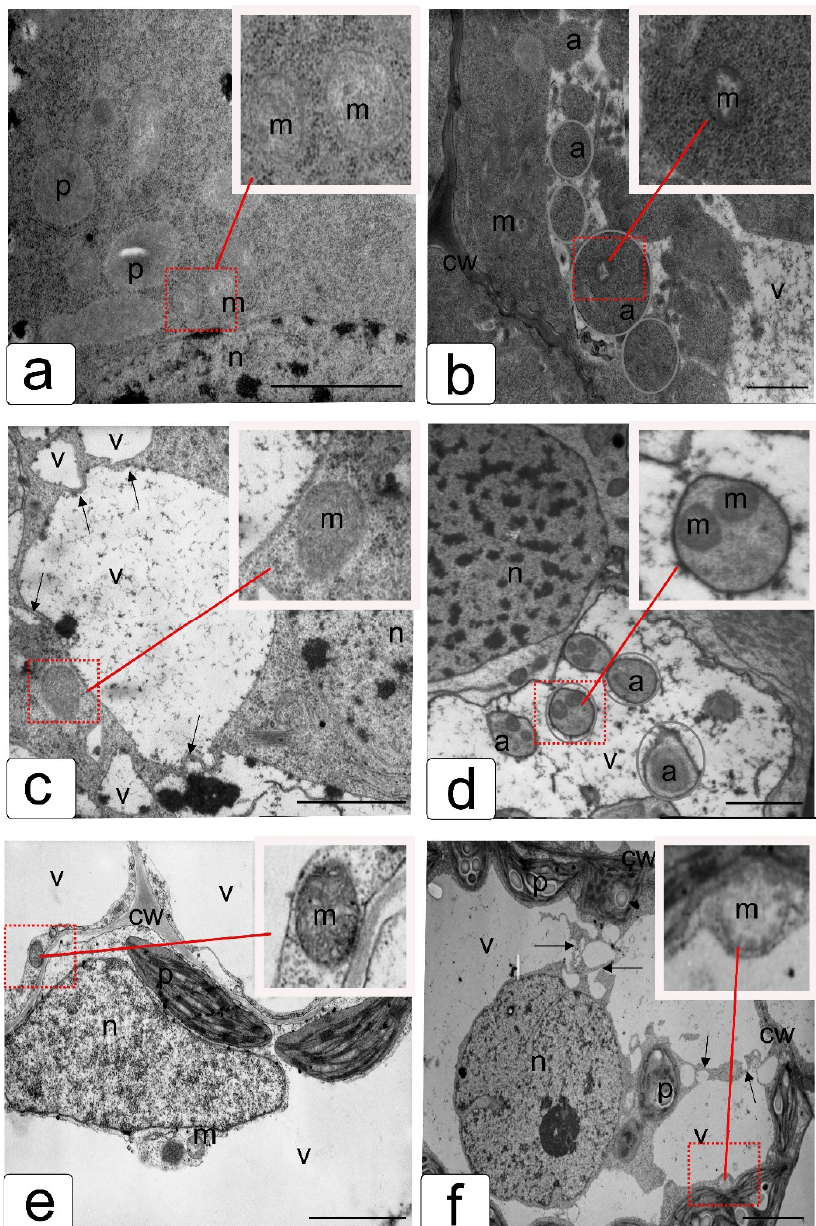
Figure 4. Formation and fusion of vacuoles and autophagosomes in cells of the root cortex ( a – d ) and aerial part ( e , f ) under control conditions and ( a , c , e ) under the influence of 150 mM NaCl. Designa- tions: p—plastid; m—mitochondria; cw—cell wall; n—nucleus; v—vacuoles; a—autophagosomes; arrows point to the vacuole fusion sites; Red arrows indicate the position of the enlarged fragment with inserts with mitochondria. Bar 3 μ m.